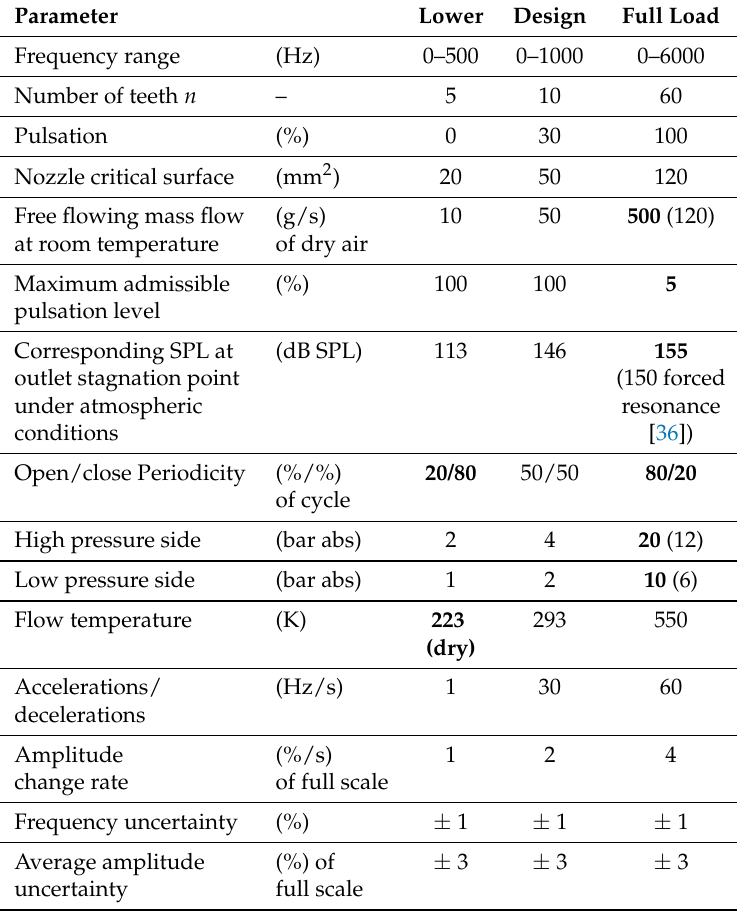
Table 1. Performance sheet of the third generation siren. Values in bold are theoretical; others, including between parenthesis, were proven